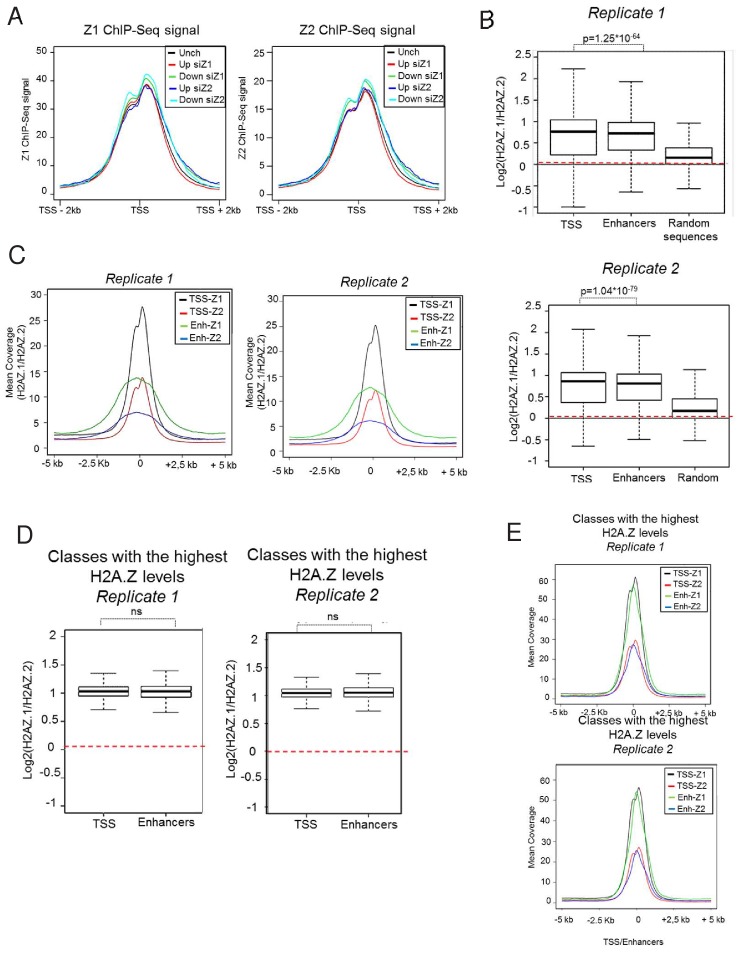
Analysis of H2A.Z.1 or H2A.Z.2 presence around TSS and enhancers.(A) Replicates of ChIP-Seq experiments using Flag antibodies from U2OS cells expressing either genome edited H2A.Z.1 (left) or H2A.Z.2 (right) analysed as in Figure 2C. (B) Box plots representing the ratio of the mean amount of H2A.Z isoforms ChIP-Seq signals around all TSS (59,553 TSSs), at all U2OS enhancers (obtained through enhanceratlas: http://www.enhanceratlas.org/, 14,764 enhancers) and at 1000 random genomic sequences of 1000 bases. (C) Metadata showing the mean of H2A.Z.1 and H2A.Z.2 ChIP Seq signals on the 10 kB region encompassing all TSSs and all enhancers. For enhancers, the ‘0’ position corresponds to the centre of enhancers defined in enhanceratlas. (D) TSSs and enhancers were sorted in five classes according to the total levels of H2A.Z. The box plots show the ratio of the mean amount of H2A.Z isoforms ChIP-Seq signals around TSS (24,695/22,263 TSSs), and U2OS enhancers (1,707/1,459 enhancers) falling into the highest class (4 < ln (H2A.Z.1 + H2A.Z.2 ChIP-Seq signals)<5). (E) Metadata showing the mean of H2A.Z.1 and H2A.Z.2 ChIP Seq signals on the 10 kB region encompassing the TSS and enhancer populations defined in D). For enhancers, the ‘0’ position corresponds to the centre of enhancers defined in enhanceratlas.